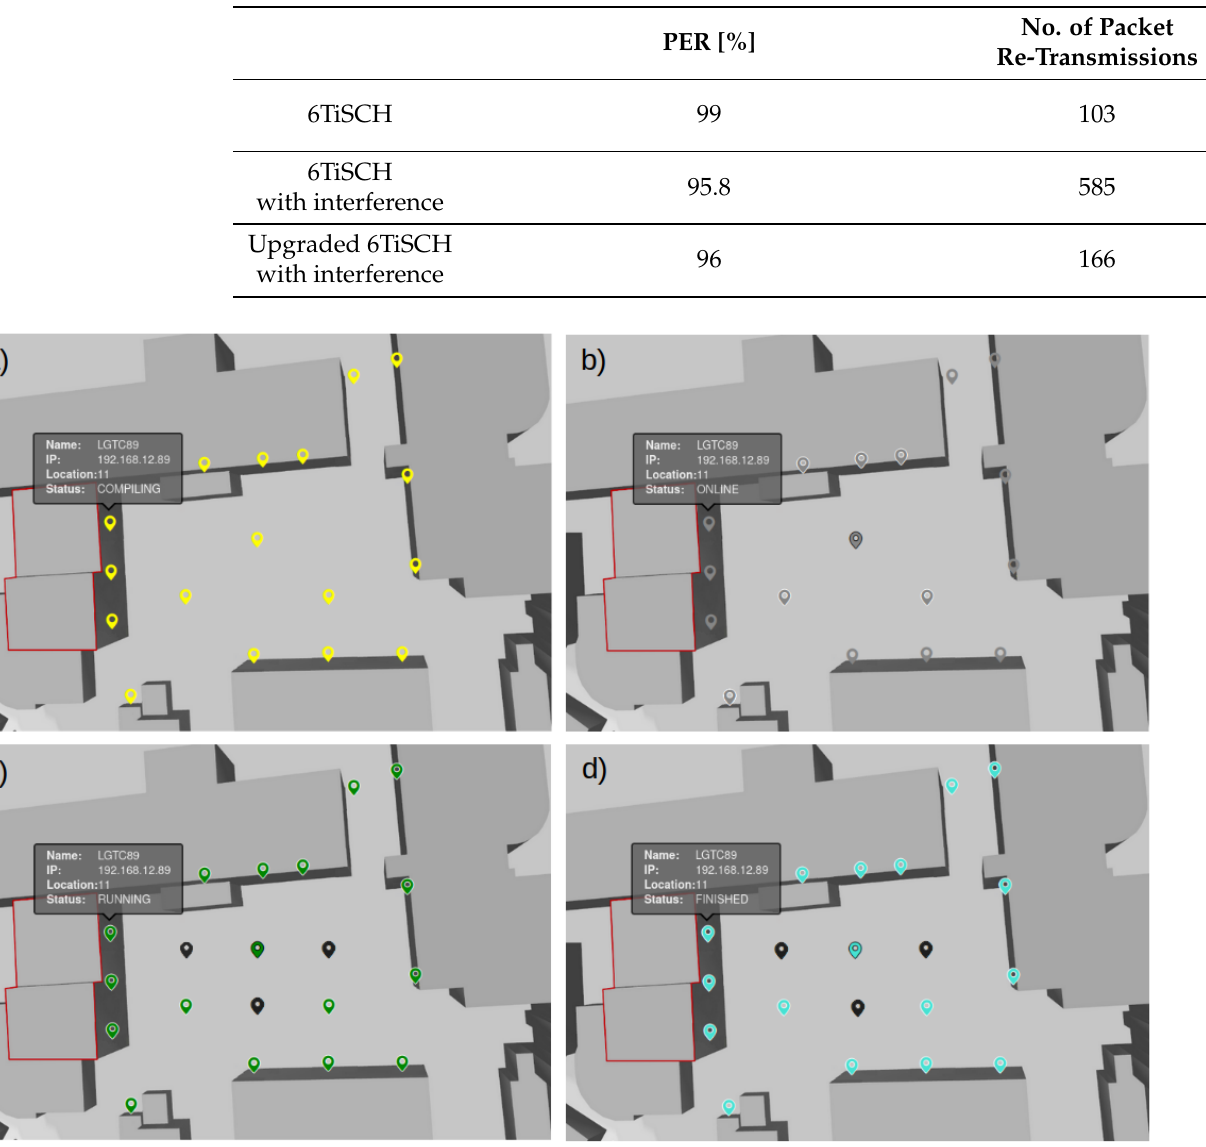
Table 2. Experiment results.